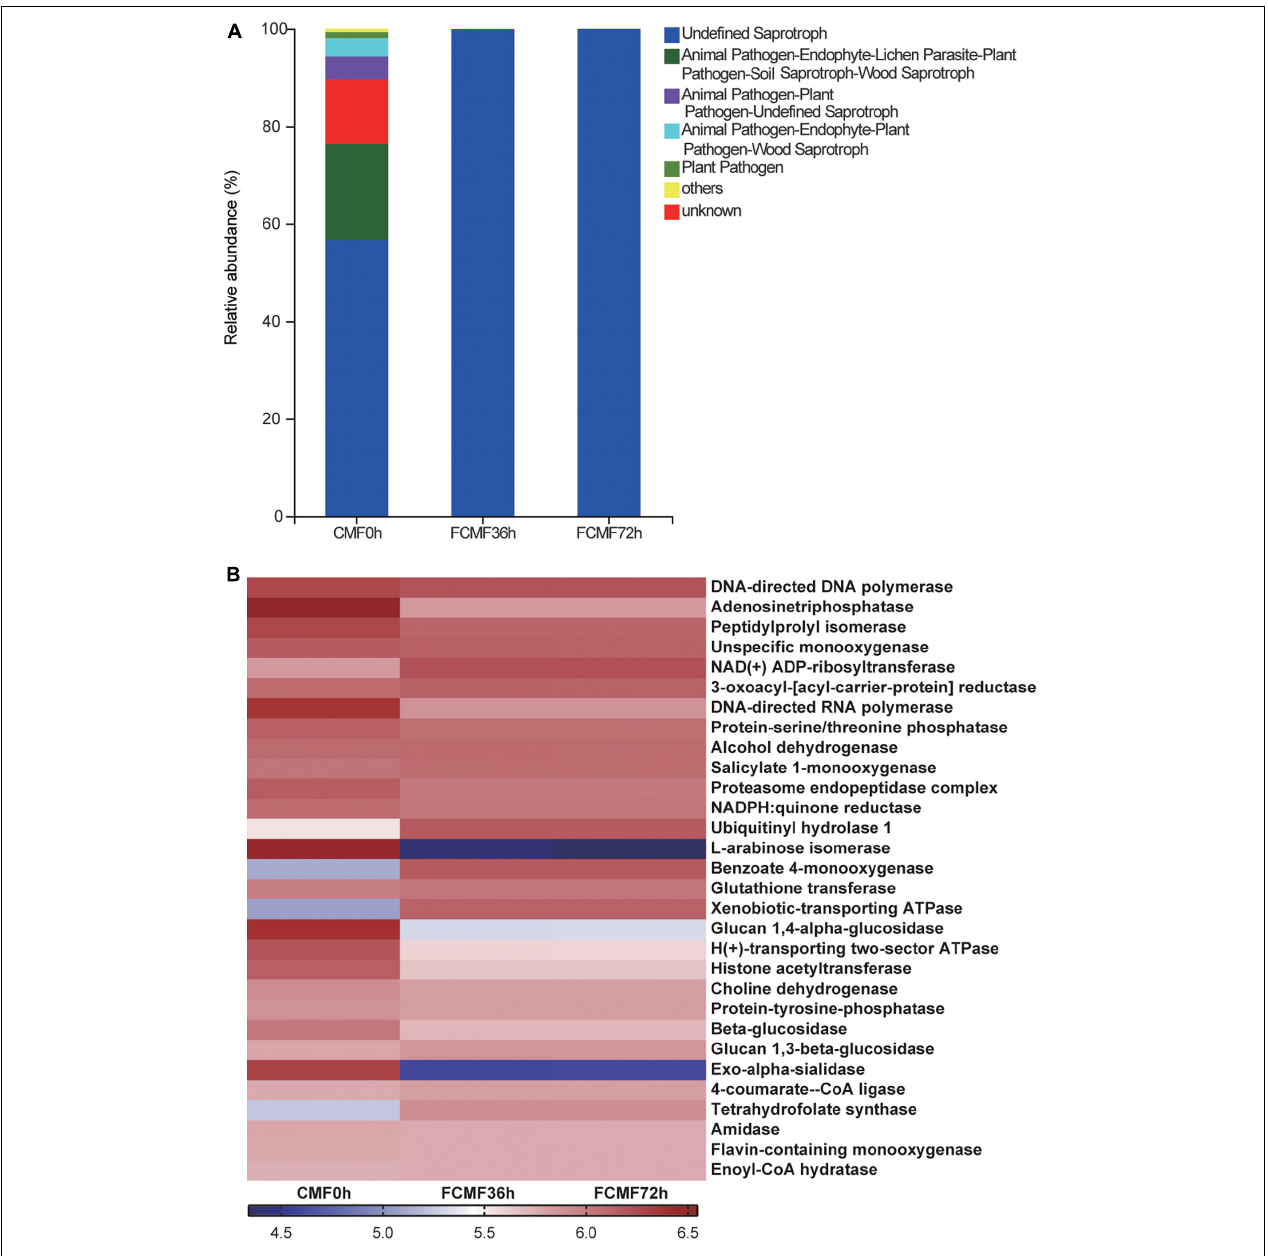
FIGURE 6 | Dynamics of fungal functional profiles during CMF fermentation process analyzed by FUNGuild and PICRUSt ( n = 3). (A) Variations in composition of fungal functional groups inferred by FUNGuild. (B) Level 3 KEGG ortholog functional predictions of the relative abundances of the top 30 enzymes.